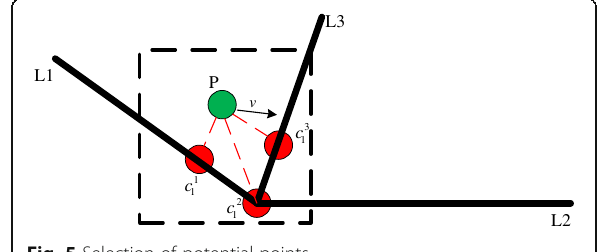
Fig. 5 Selection of potential